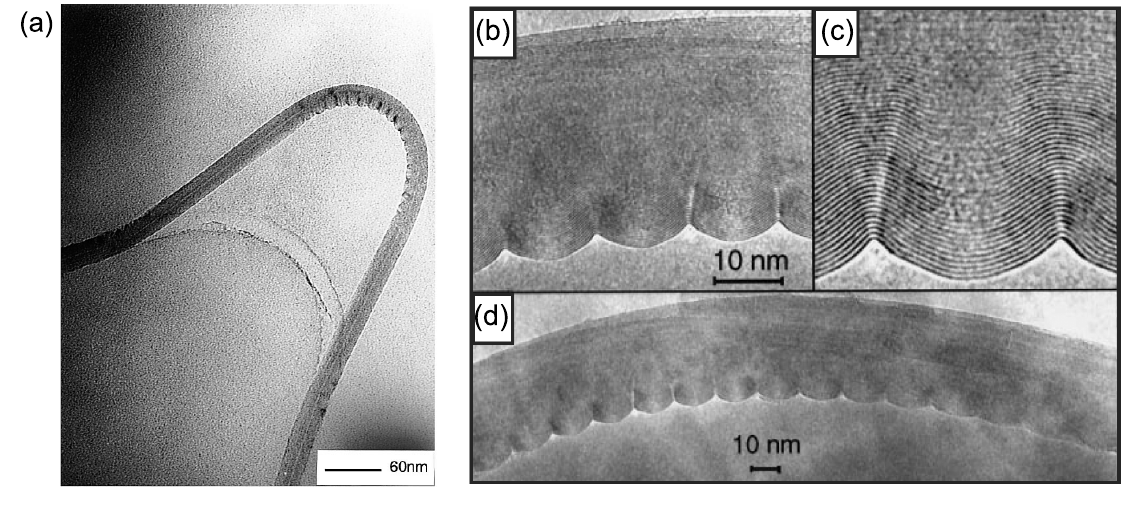
Figure 13. ( a ) Under high bending, MWNTs form kinks on the internal (compression) side of the bend; ( b )–( d ) High-resolution TEM image of a bent nanotube (with a radius of curvature of ∼ 400 nm), showing the characteristic wavelike distortion. The amplitude of the ripples increases continuously from the center of the tube to the outer layers of the inner arc of the bend. Reprinted from References